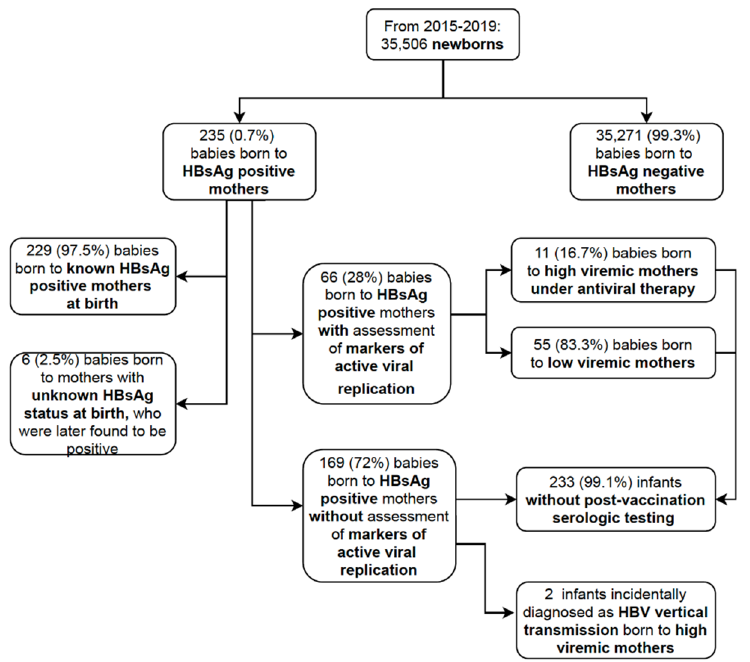
Figure 1. Flowchart outlining the study population selection.